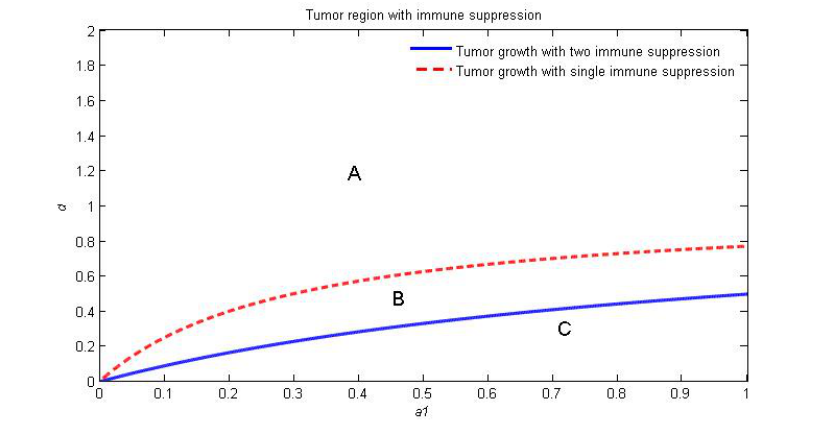
Figure 20. Regions of the stability of a 1 and d are obtained. d represents the total cell loss at mitosis. Region A represents tumour decay and Region B and C represent tumour growth. When two immune suppressions are added, the curve lies consistently below the curve with single immune